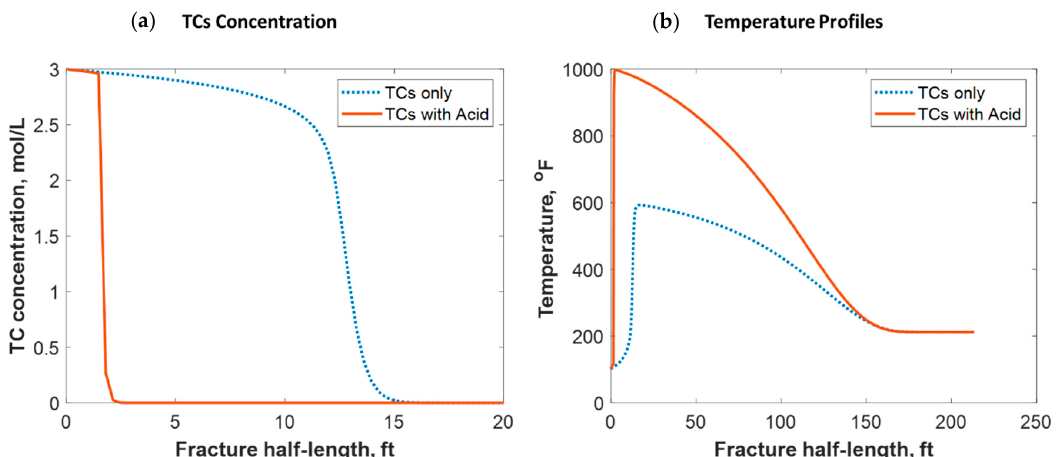
Figure 17. Comparison of ( a ) TC concentrations and ( b ) fluid temperature profiles along the fracture half-length when only TCs were injected versus TCs with acid.